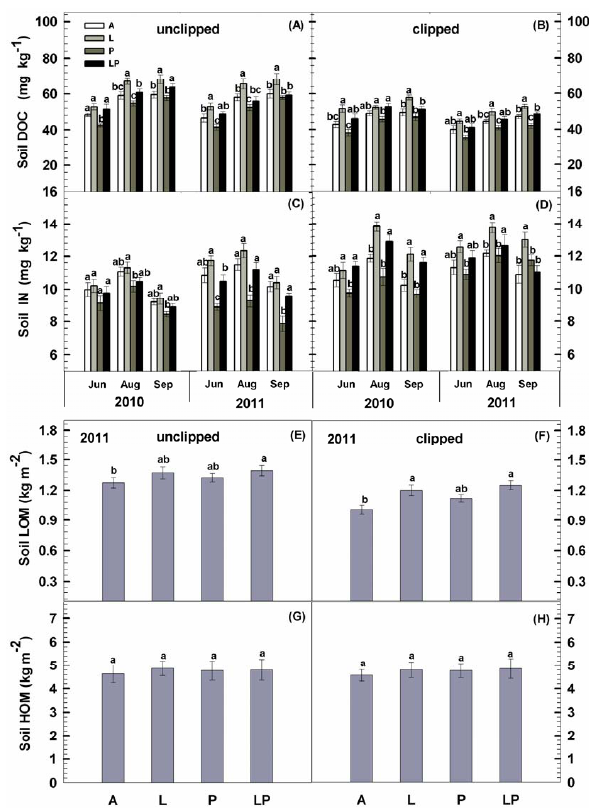
Fig. 3. Responses of soil dissolved organic C (DOC), inorganic N (IN), soil light organic matter (LOM) and heavy organic mat- ter (HOM) to belowground particulate litter addition ( + 60%), in- creased precipitation ( + 30%) and clipping in the temperate steppe of northeastern China. Vertical bars indicate standard error of means ( n = 6). Different lowercase letters indicate statistically significant differences ( P < 0.05). See Fig. 2 for